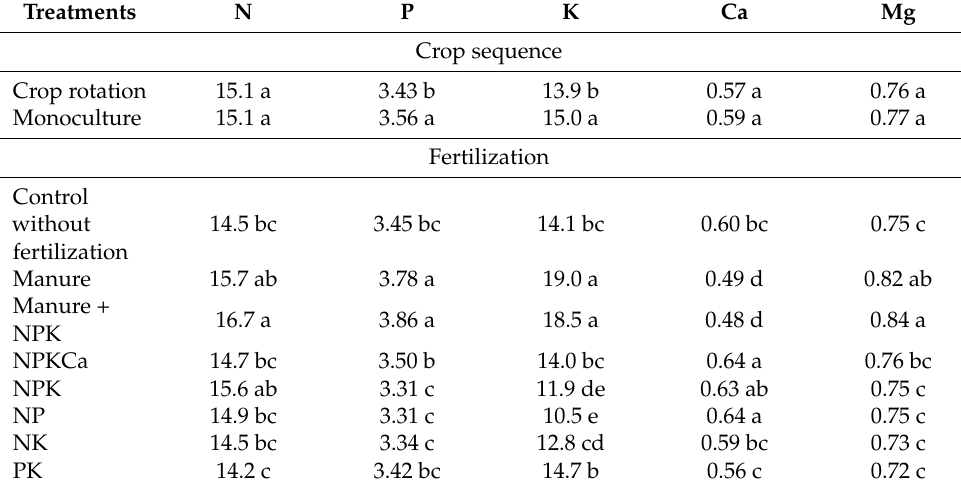
Table 5. Content of macronutrients in the dry matter of potato tubers, g/kg (mean of 2007–2013). Treatments N P K Ca Mg Crop sequence Crop rotation 15.1 a 3.43 b Monoculture 15.1 a 3.56 a